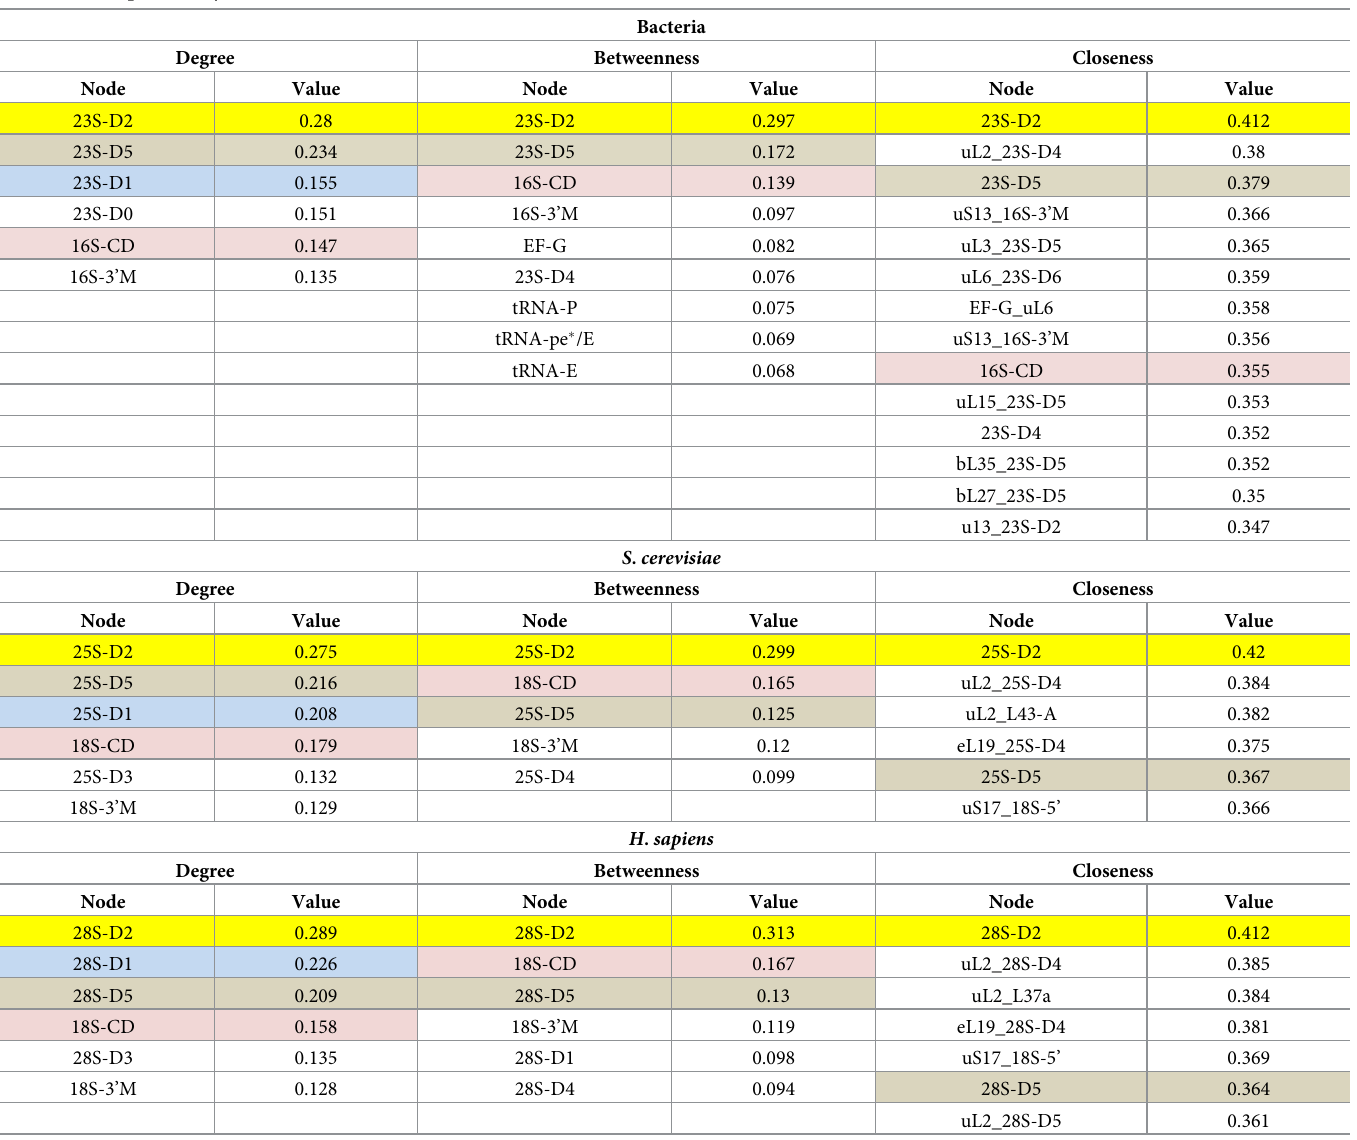
Table 4. Ave top centrality values.